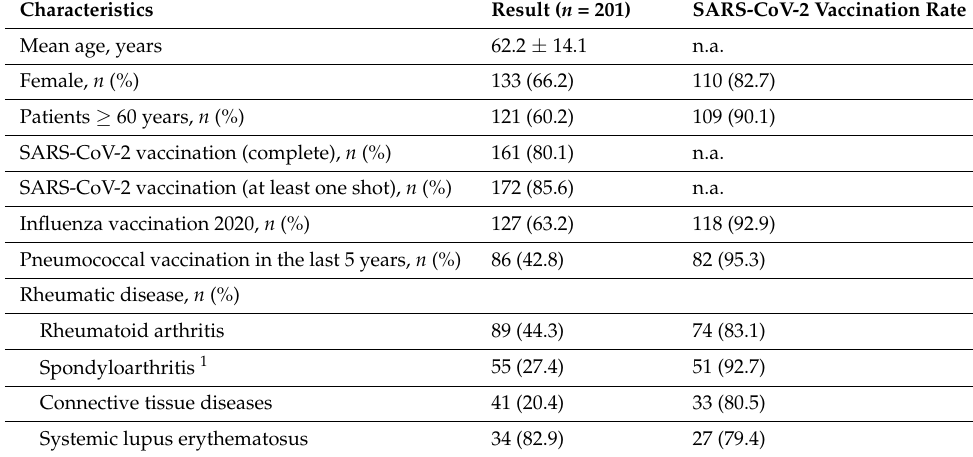
Table 1. Clinical characteristics of the included patients ( n = 201). Numbers are shown as % or mean with standard deviation